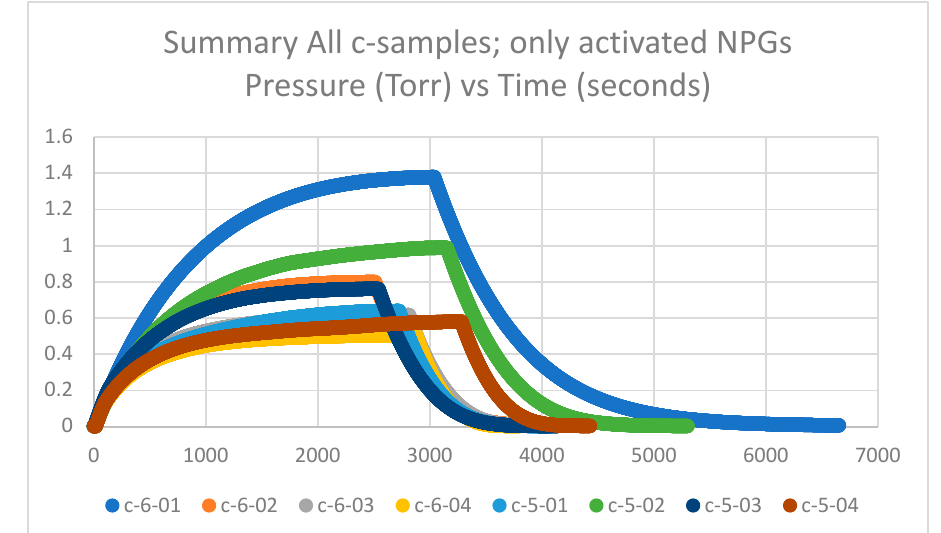
Figure 1. Summary of getter rate tests for all NPG c-samples (getter tubes 5 and 6; only activated) with pressure in Torr vs. time in seconds.